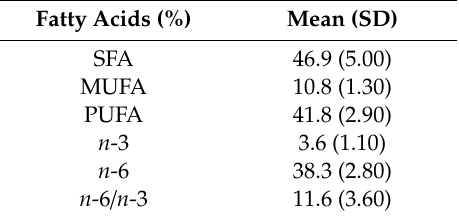
Table 4. Fatty acid composition of plasma phospholipids in a sample of Serbian adults ( n =